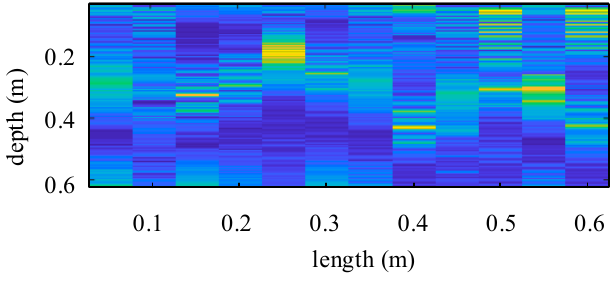
Figure 24. B-Scan echo in single channel.